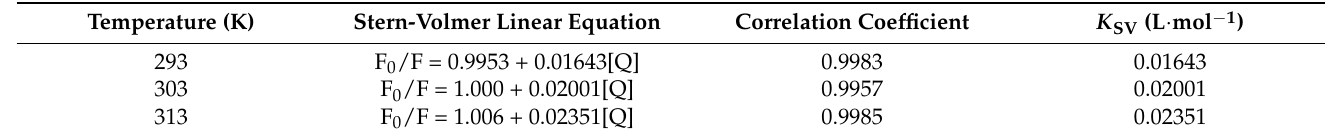
Figure 7. ( a ) Stern–Volmer curves of F 0 /F vs. concentration of CIP at different temperature; ( b ) fluorescence decay curves of GMPA@CdTe QDs in the absence and presence of CIP; ( c ) the UV spectrum of CIP and the fluorescence excitation and emission spectra of GMPA@CdTe QDs; ( d ) UV spectra of GMPA@CdTe QDs, CIP, and GMPA@CdTe QDs–CIP. Table 2. Parameters of Stern-Volmer